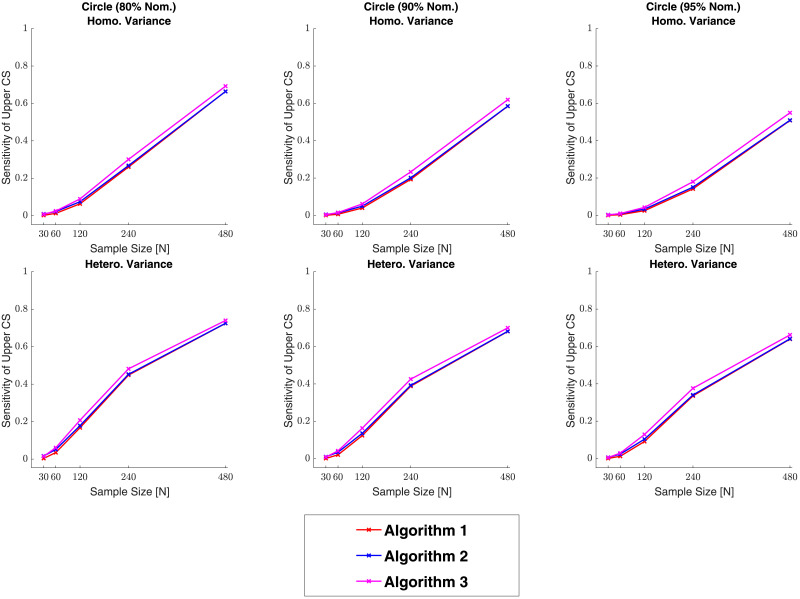
Sensitivity results for the circular signal, with homogeneous (top row) and heterogeneous (bottom row) Gaussian noise structures.